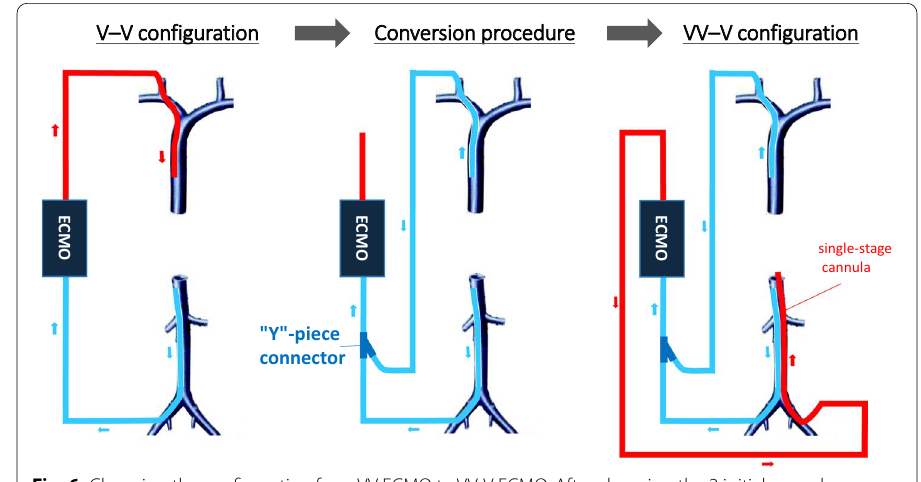
Fig. 6 Changing the configuration from VV ECMO to VV-V ECMO. After clamping the 2 initial cannulas, tubings can be cut in conserving some length. An Y-piece connector is then positioned to reunite these 2 tubings. This Y-piece is also connected to the drainage tubing of ECMO system. Oxygenator used in V-V configuration may be conserved or changed if its performance is too altered. All tubings must be totally purged of air before connection. A complementary tubing may be necessary on return line between ECMO system and returning cannula if oxygenator is conserved. Once totally purged of air, returning cannula may be connected to the ECMO system and VV-V extracorporeal circulation may be started. In our experience, the femoral/jugular couples (29Fr–55 cm)/(22Fr–15 cm) and (27Fr–61 cm)/(20Fr–15 cm) have good balance in term of drainage, with flow percentages frequently comprised between 60%/40% and 70%/30%,